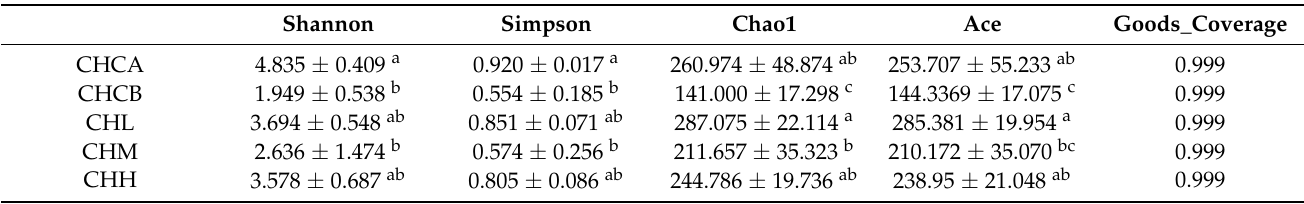
Table 1. The alpha diversity of intestinal microbiota in mice.